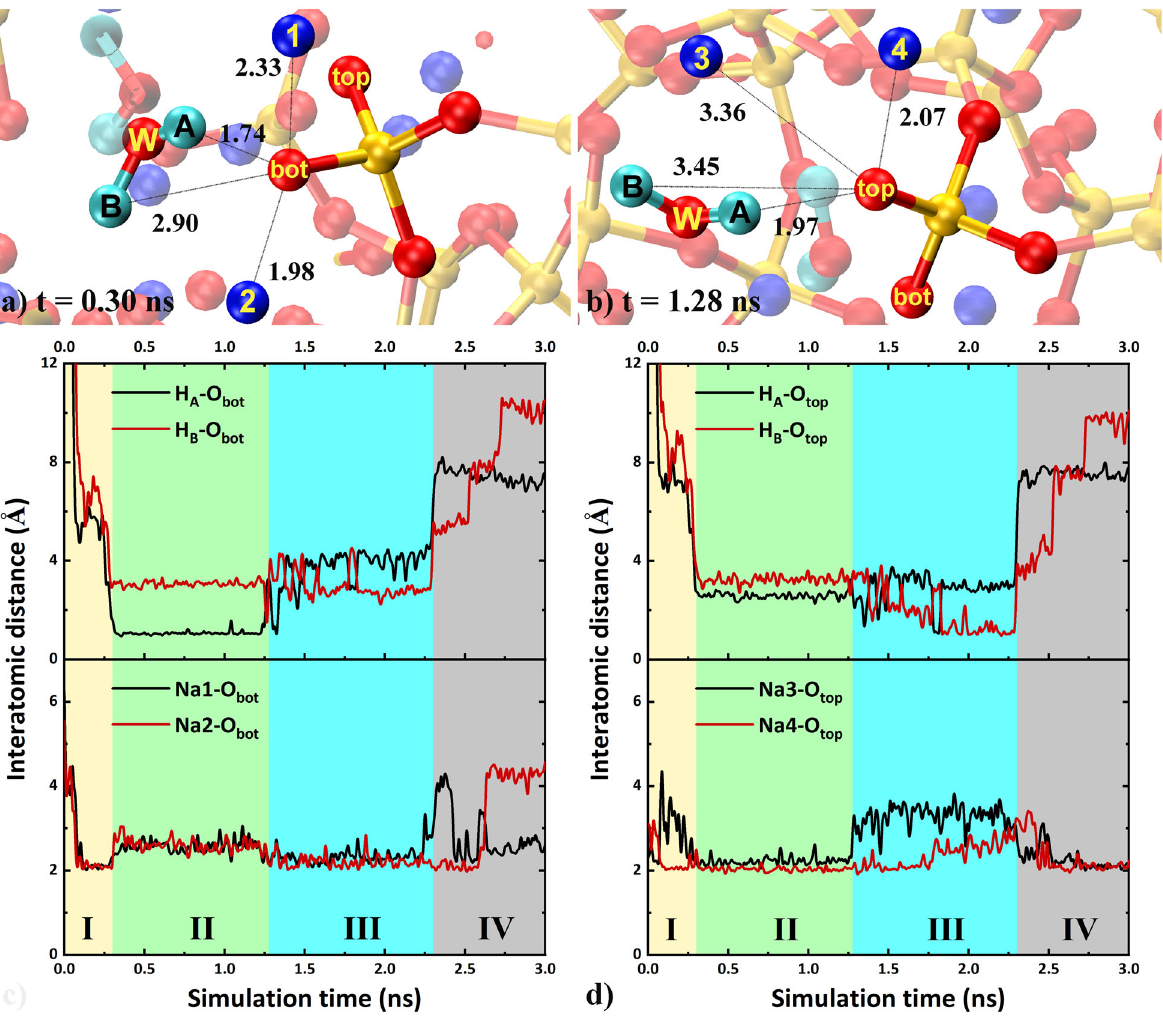
Fig. 5 H – O and Na – O bond distance evolutions during the self-exchange silanol re-formation reactions. a , b The snapshots of the local environment of bottom (0.3 ns) and top NBO − (at 1.28 ns) atoms in self-exchange silanol re-formation process, in which A, B represent two hydrogen atoms and 1, 2, 3, 4 represent four sodium ions around the two non-bridging oxygen (NBO) represented as top and bot (bottom), W represents oxygen on a molecular water. c , d Distances between the monitored species (H + or Na + ) and NBOs (O bot or O top ) versus the simulation time,